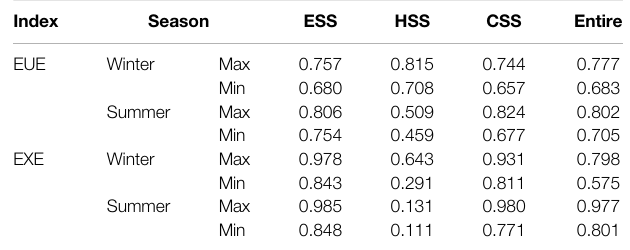
TABLE 4 | The energy ef fi ciency of EPP.